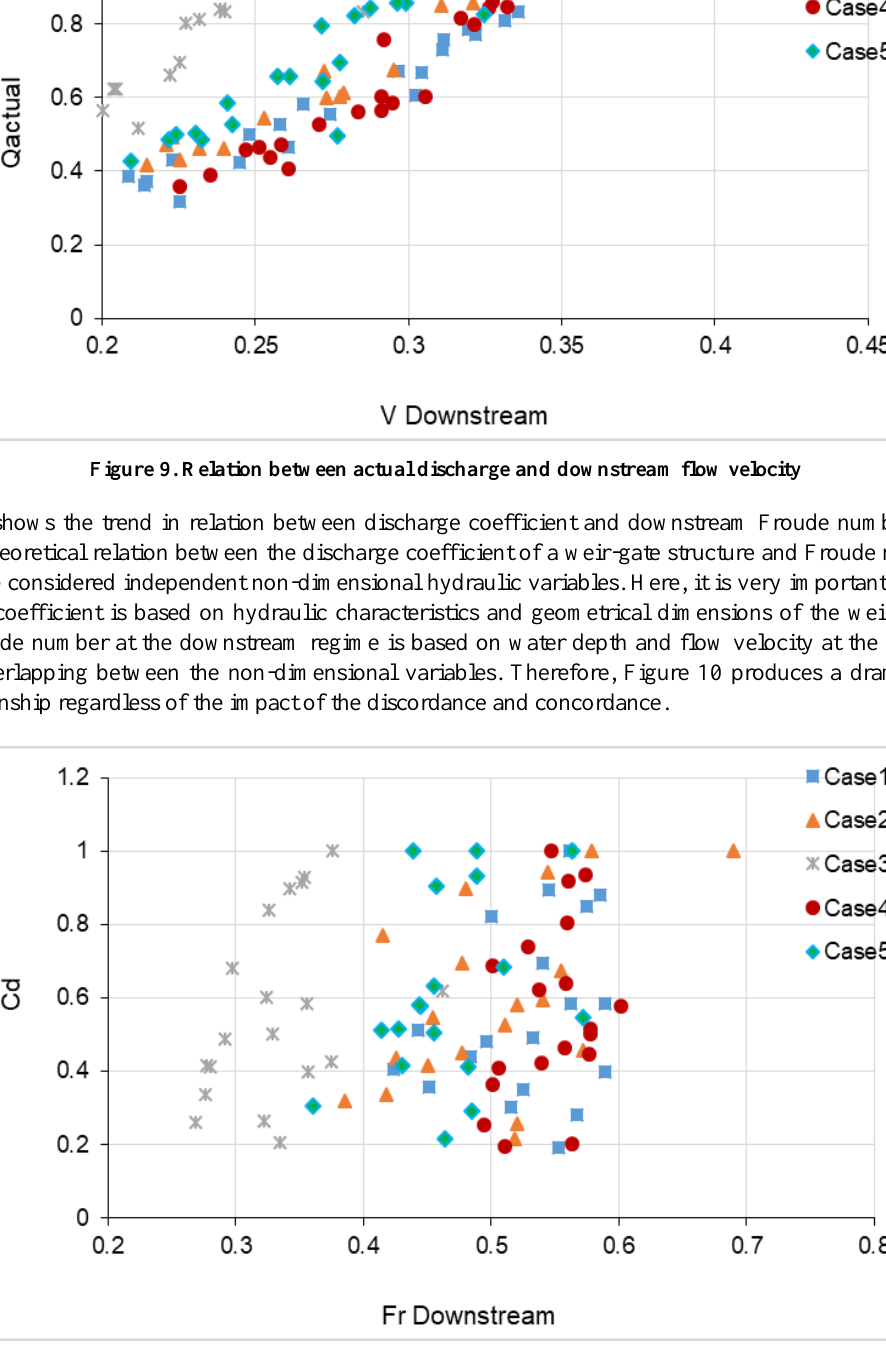
Figure 10. Relation between discharge coefficient and Froude number at